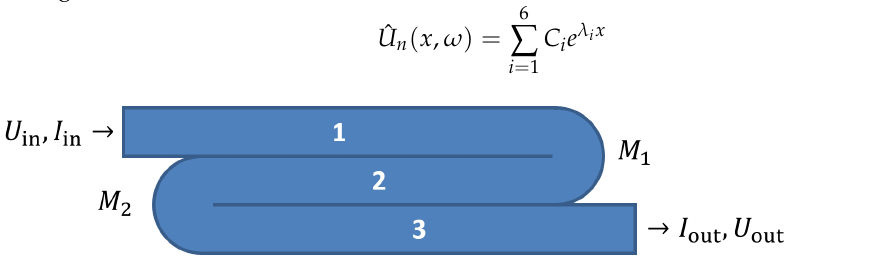
Figure 9. A schematic image of an example with three traxels, indicating the layout for the implicit boundary condition